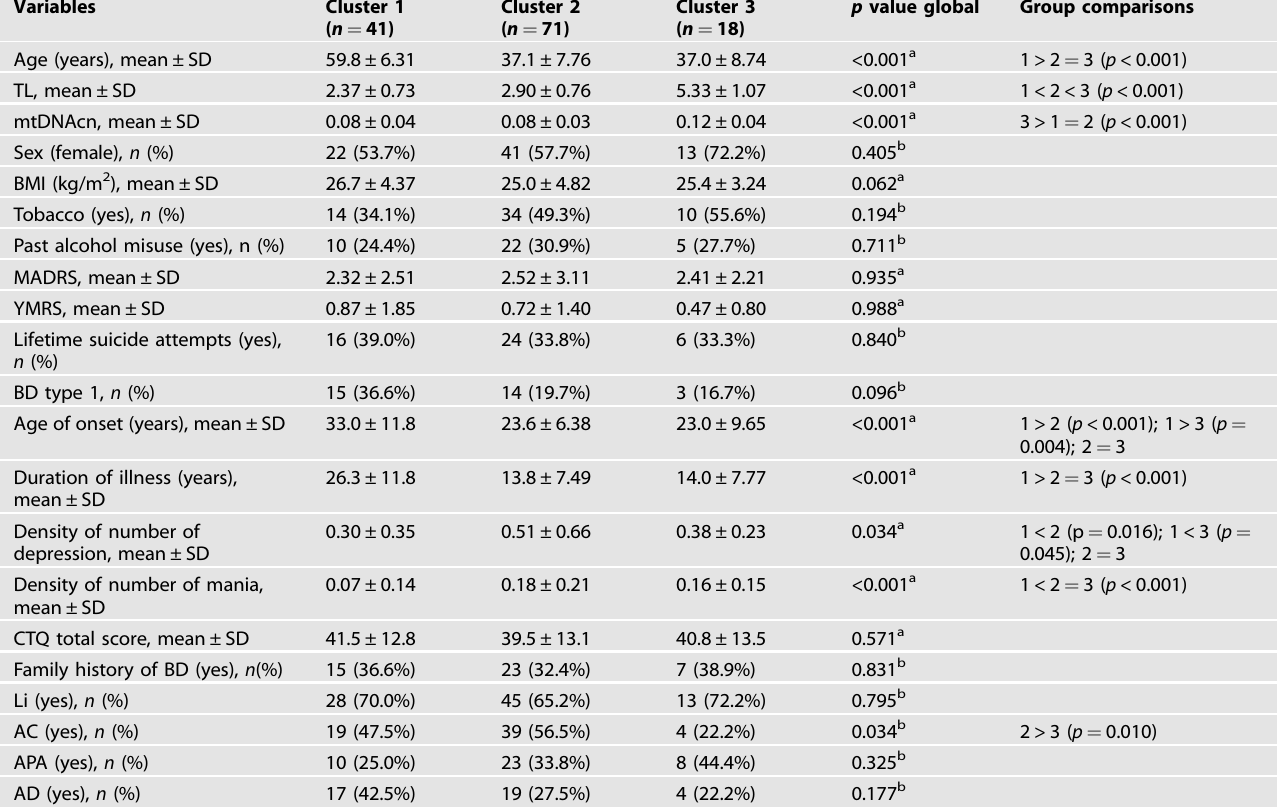
Table 2. Comparisons between the three groups resulting from the clustering analyses (individuals with BD